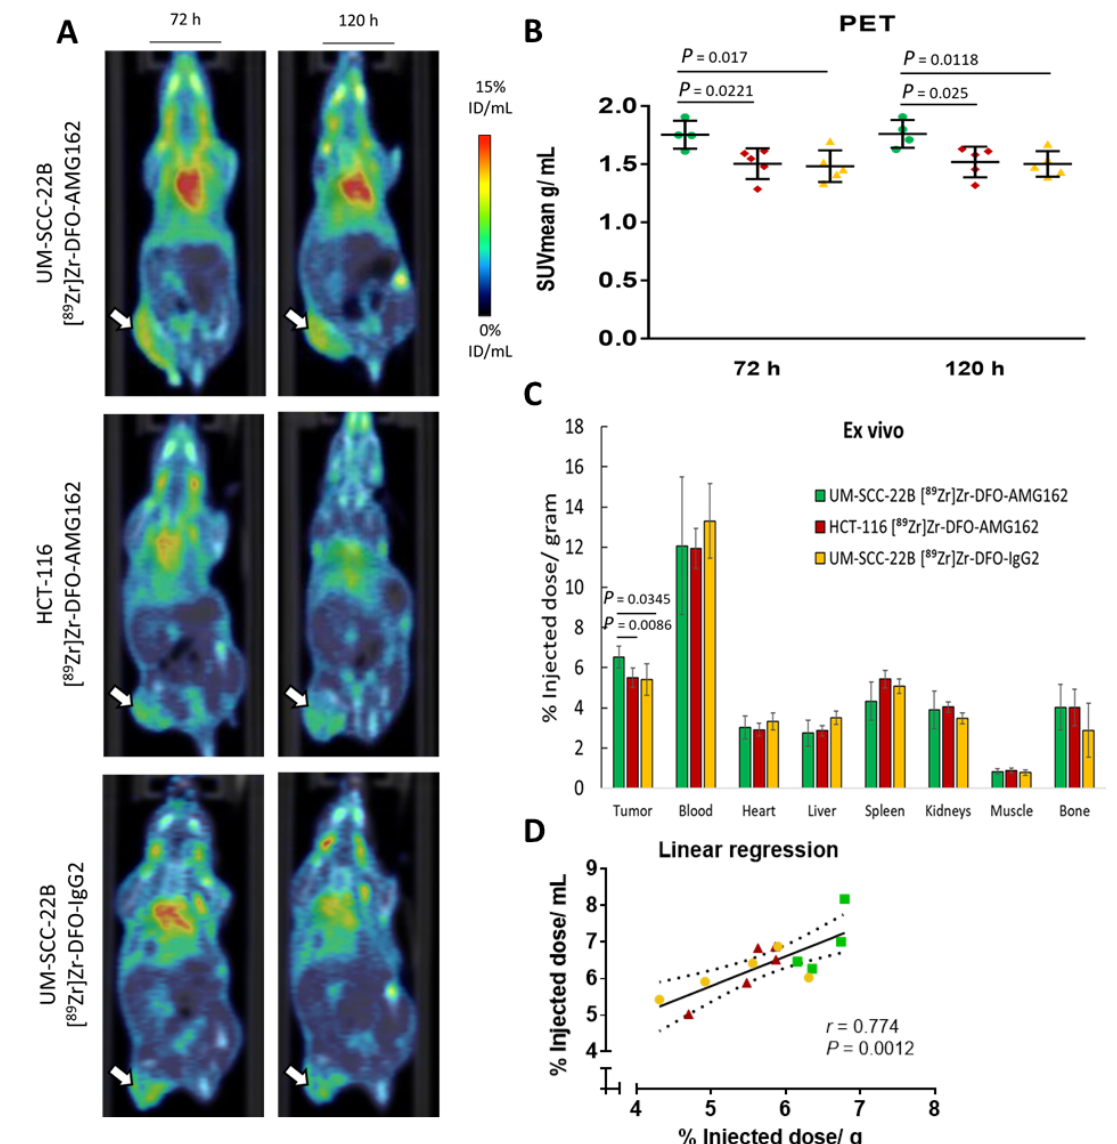
Figure 3. Overview imaging studies in UM-SCC-22B xenografts. ( A ) [ 89 Zr]Zr-DFO-AMG162 PET imaging in UM-SCC-22B (top) and HCT-116 xenografts (middle), and [ 89 Zr]Zr-DFO-IgG2 in UM-SCC-22B (bottom) at 72 h and 120 h p.i. ( B ) Difference in tumor uptake (SUV mean g/mL) assessed via PET between UM-SCC-22B and HCT-116 xenografts imaged with [ 89 Zr]Zr-DFO-AMG162 or [ 89 Zr]Zr-DFO-IgG2 at 72 h and 120 h p.i. ( C ) Difference in tumor uptake as assessed ex vivo (% ID/g) between [ 89 Zr]Zr-DFO-AMG162 and [ 89 Zr]Zr-DFO-IgG2 in UM-SCC-22B and HCT116, and UM-SCC-22B xenografts, respectively. ( D ) Linear regression in UM-SCC-22B and HCT-116 xenografts between in vivo PET imaging and ex vivo measurements of [ 89 Zr]Zr-DFO-AMG162 or [ 89 Zr]Zr-DFO-IgG2 ( r = 0.774, p = 0.0012). (Green bars: [ 89 Zr]Zr-DFO-AMG162 in UM-SCC-22B xenografts, Red bars: [ 89 Zr]Zr-DFO-AMG162 in HCT-116 xenografts, Yellow bars: [ 89 Zr]Zr-DFO-IgG2 in UM-SCC-22B xenografts, Animals per timepoint in groups: n = 4–5, Data graph: mean +/ − 1 standard deviation, White arrows: tumor, SUV mean : mean standard uptake value, ID/mL: injected dose/mL, Statistical analysis: unpaired student t -test).